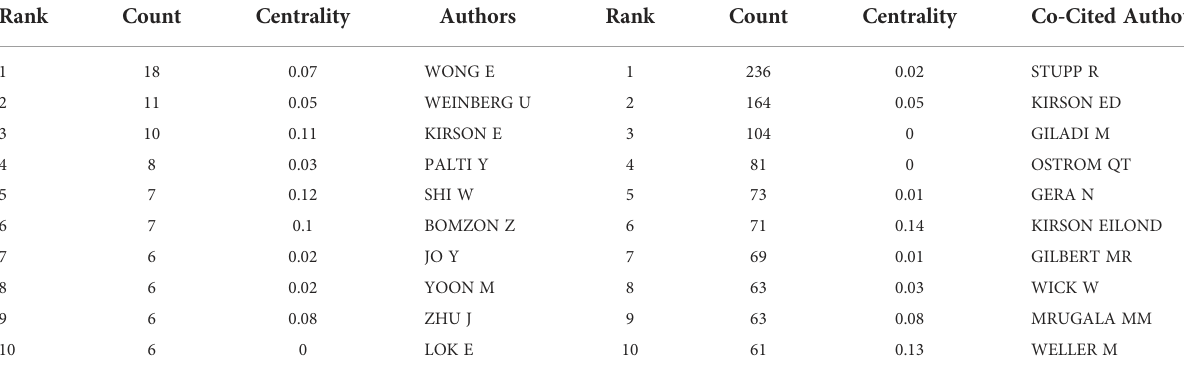
TABLE 2 Top 10 authors and co-cited authors in relevant publications from 2007 to September